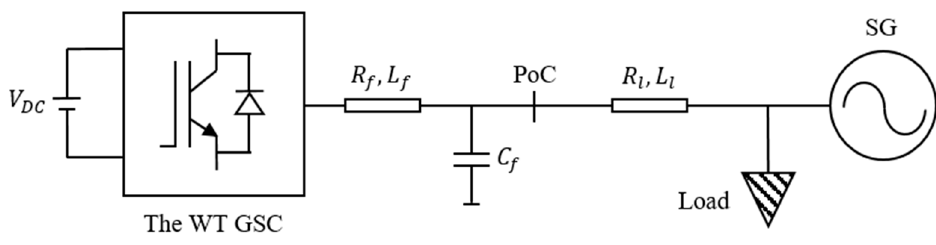
Figure 2. The simulation model .